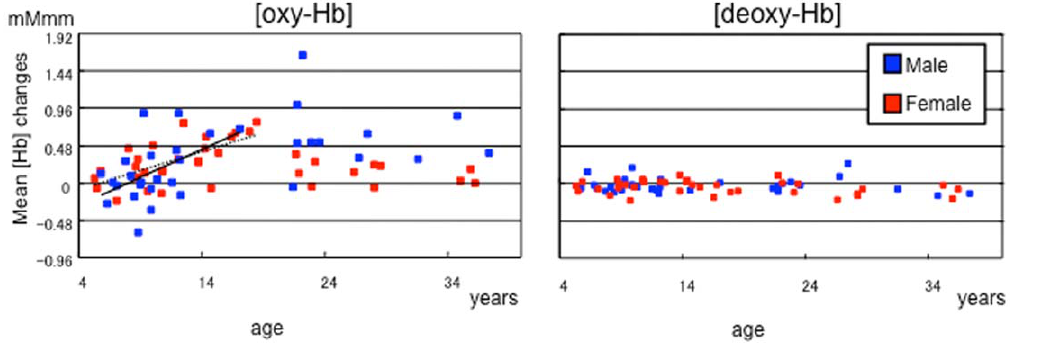
Figure 4. The scatter plots of age and the mean D Hb of the hemispheres. Left: D oxy-Hb, right: D deoxy-Hb, blue: male, red: female. Contrary to the strongly positive correlation between D oxy-Hb and age in the child/adolescent group (male: r=0.50, p=.017; female: r=.67, p , .001), the correlation coefficient was slightly negative but not statistically significant in the adult group.